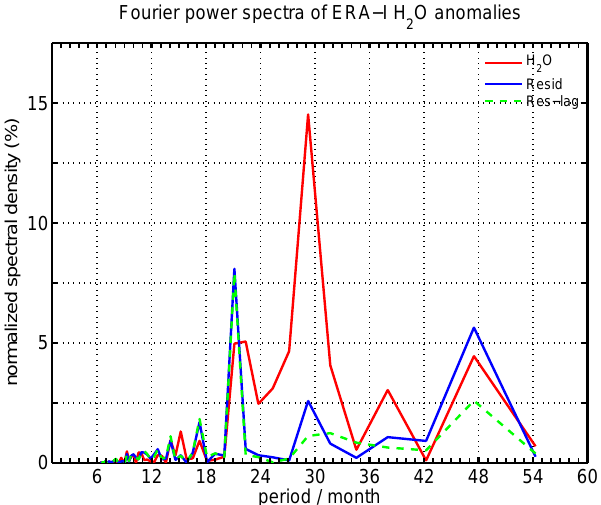
Fig. A3. As in Fig. A2 but for the tropical Fig. A1. Fourier power spectra of the detrended time series anoma- Fig.17. AsinFig. 16butforthetropicalupwelling. Fig. 15. Fourier power spectra of the detrended time series anomalies of the mean specific humidity of ERA-I lies of the mean specific humidity of ERA-I at the 100- and 70hPa atthe100-and70 hPa levels. Wecomputedthemeanofthesetwolevelstohaveamoredirectcomparisonwith levels. We computed the mean of these two levels to have a more the spectra shown in Fig. 14, which were computed for satellite water vapour data at 82 hPa . The blue curve direct comparison with the spectra shown in Fig. 14, which were showsthespectrumoftheresidualtimeseries,i.e. thewatervapourtimeseriesaftertheQBO,ENSOandsolar computed for satellite water vapour data at 82hPa. The blue curve cycle signals have been removed by a multilinear regression. The dashed green curve represents the spectrum shows the spectrum of the residual time series, i.e., the water vapour oftheresidualtimeseriesoftheERA-IwatervapouranomaliescalculatedwiththeENSOindexleadingbysix time series after the QBO, ENSO and solar cycle signals have been months. Thespectrawerenormalizedbythetotalvarianceoftheoriginaldetrendedtimeseries. removed by a multilinear regression. The dashed green curve rep- resents the spectrum of the residual time series of the ERA-I water vapour anomalies calculated with the ENSO index leading by six months. The spectra were normalized by the total variance of the original detrended time series. 33